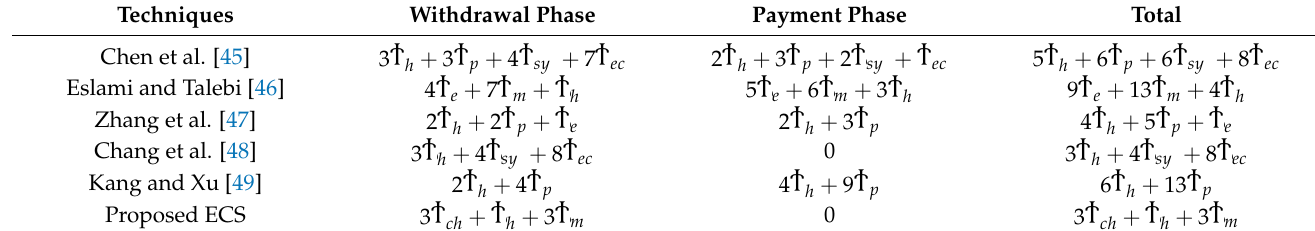
Table 2. Assessments of important operations with reverence techniques.